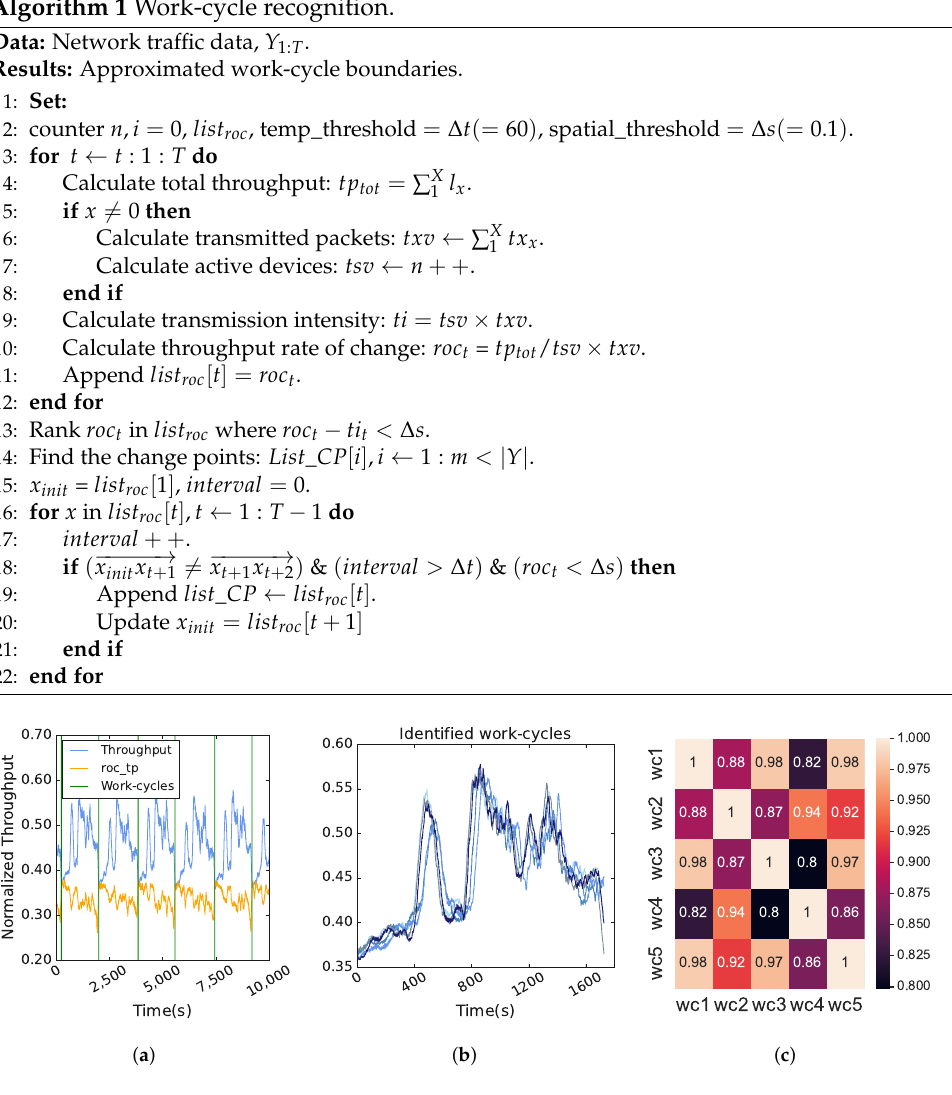
Algorithm 1 Work-cycle recognition.